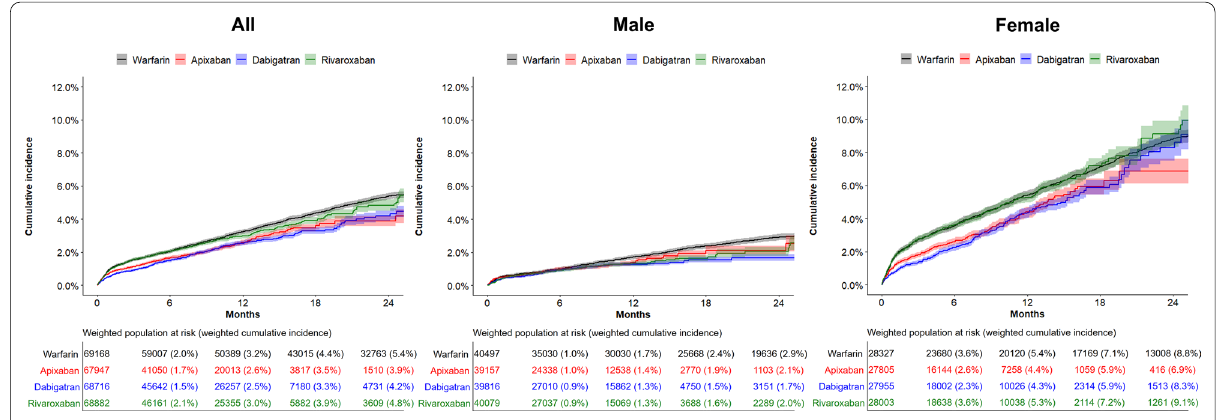
Fig. 3 Weighted cumulative incidence curves of osteoporotic fracture